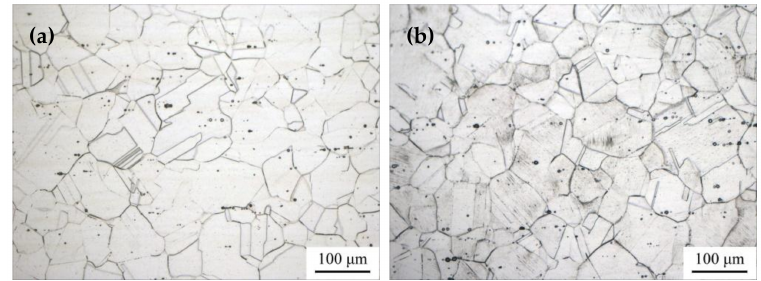
Figure 5. OM micrograph of welding thermal simulation specimens: ( a ) without additional loading; ( b ) with additional